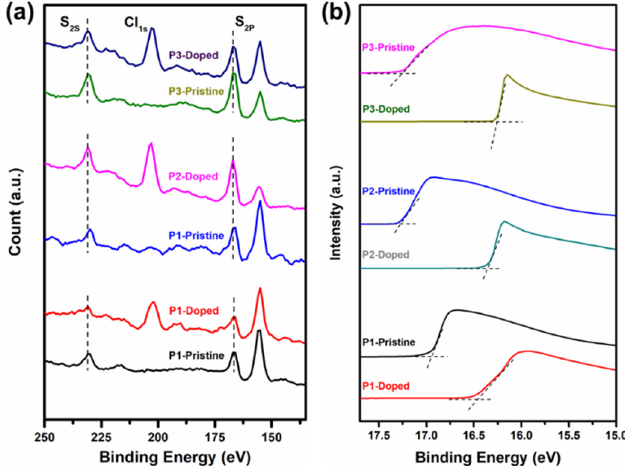
Figure 7. ( a ) XPS spectra S 2 S and S 2 P curves of pristine polymer films and films doped with FeCl 3 (0.1 M) for 15 min; ( b ) UPS spectra (He I α radiation, photon energy = 21.22 eV) showing the secondary electron cut ‐ off region for polymers in pristine and films doped with FeCl 3 (0.1 M) for 15 min.